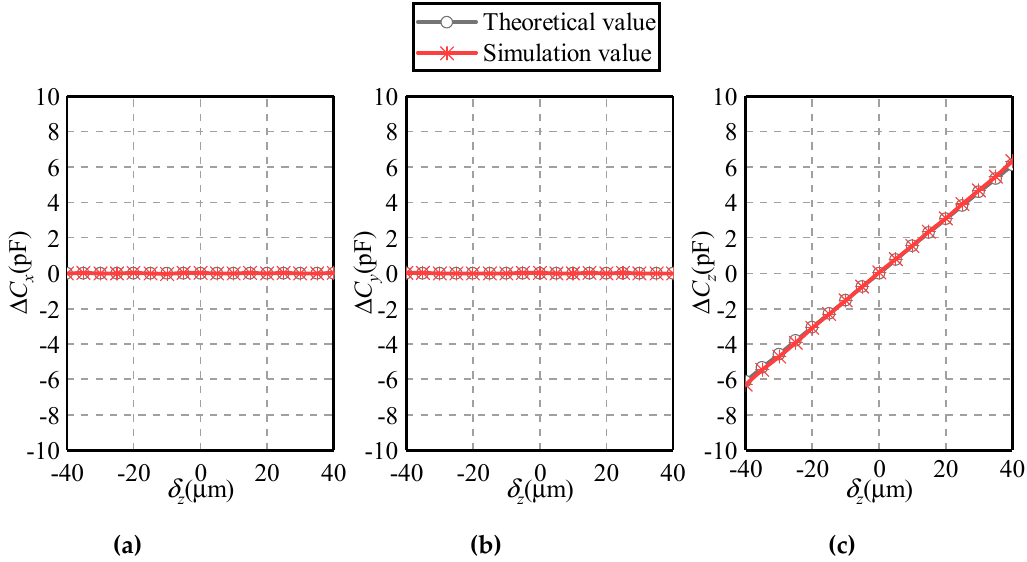
Figure 12. Dependence of the differential capacitance on the eccentric displacement along the Z -axis ( a ) Δ C x , ( b ) Δ C y and ( c ) Δ C z .